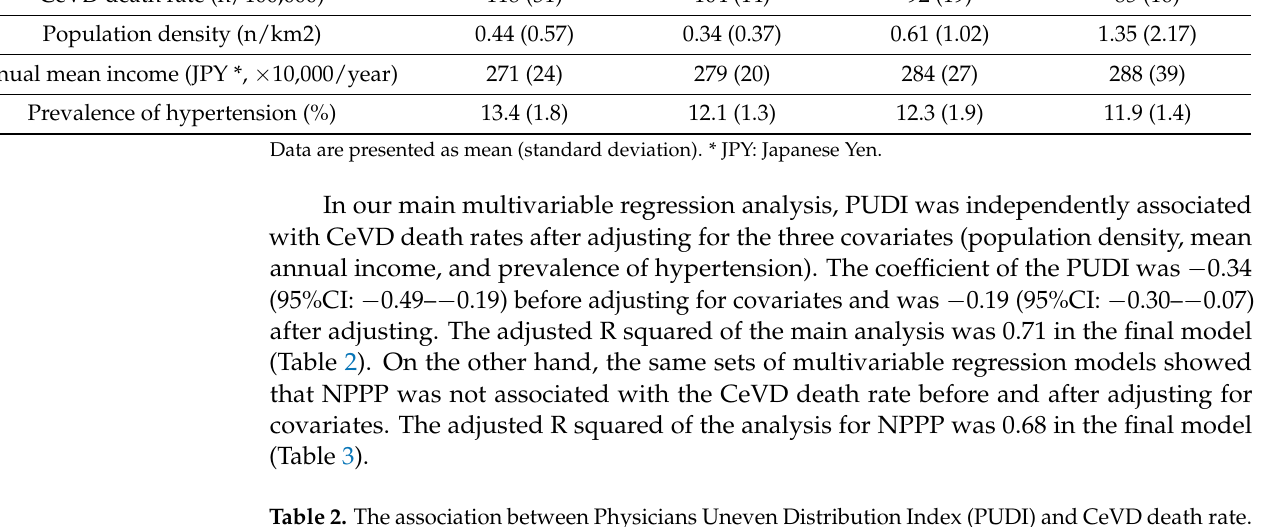
Table 2. The association between Physicians Uneven Distribution Index (PUDI) and CeVD death